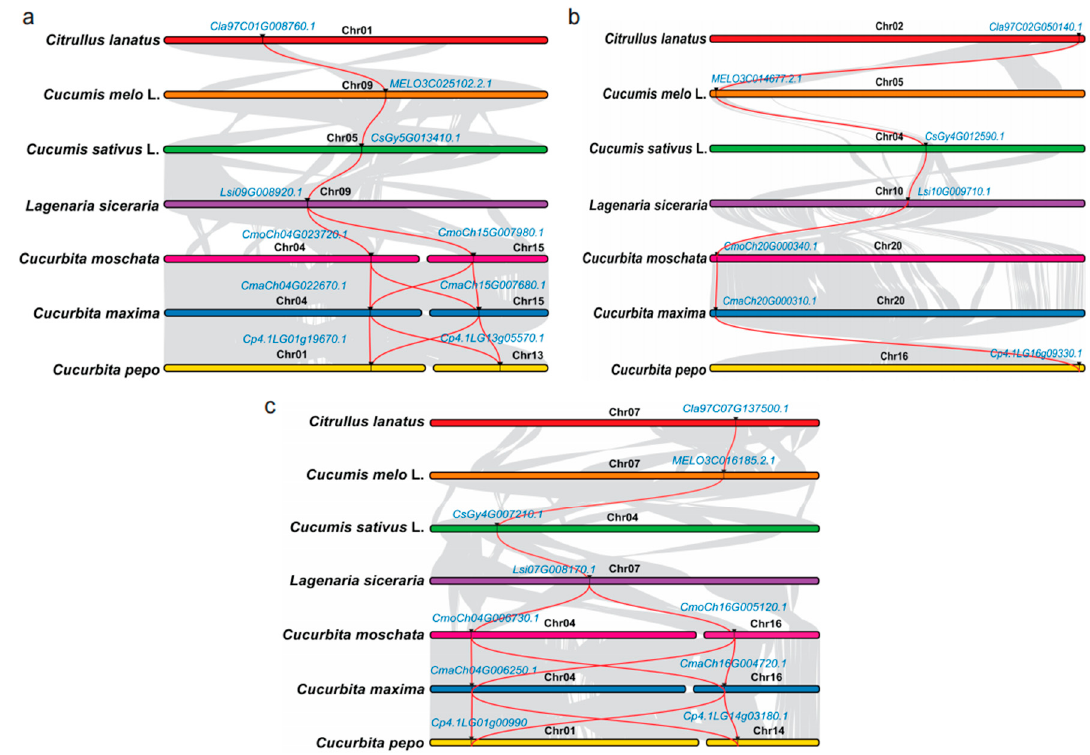
Figure 6. The synteny analysis of PSY members among different cucurbit crops. ( a – c ) for the ClPSY1 , ClPSY2 and ClPSY3 homologous genes in different cucurbit crops.